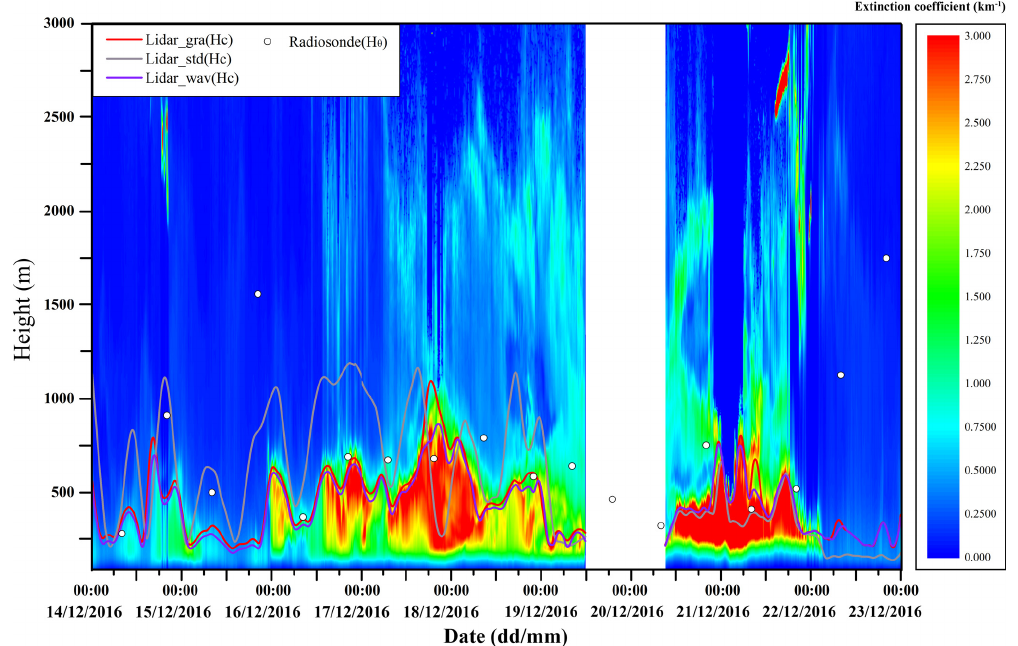
Figure 4. Temporal and spatial variations in the extinction coefficient (shaded, unit: km − 1 ) from 14 to 23 December 2016 and ABL heights (m) determined with different instruments. The red line (lidar_gra), grey line (lidar_SD) and purple line (lidar_wav) represent ABL heights determined by the lidar using the gradient method, the standard deviation method and the wavelet method, respectively. White points: ABL height determined by radiosondes. It should be noted that the blank part of the extinction coefficient can be attributed to a technical failure and that lidar data for 11:00LT on 19 December to 09:00LT on 20 December are missing.